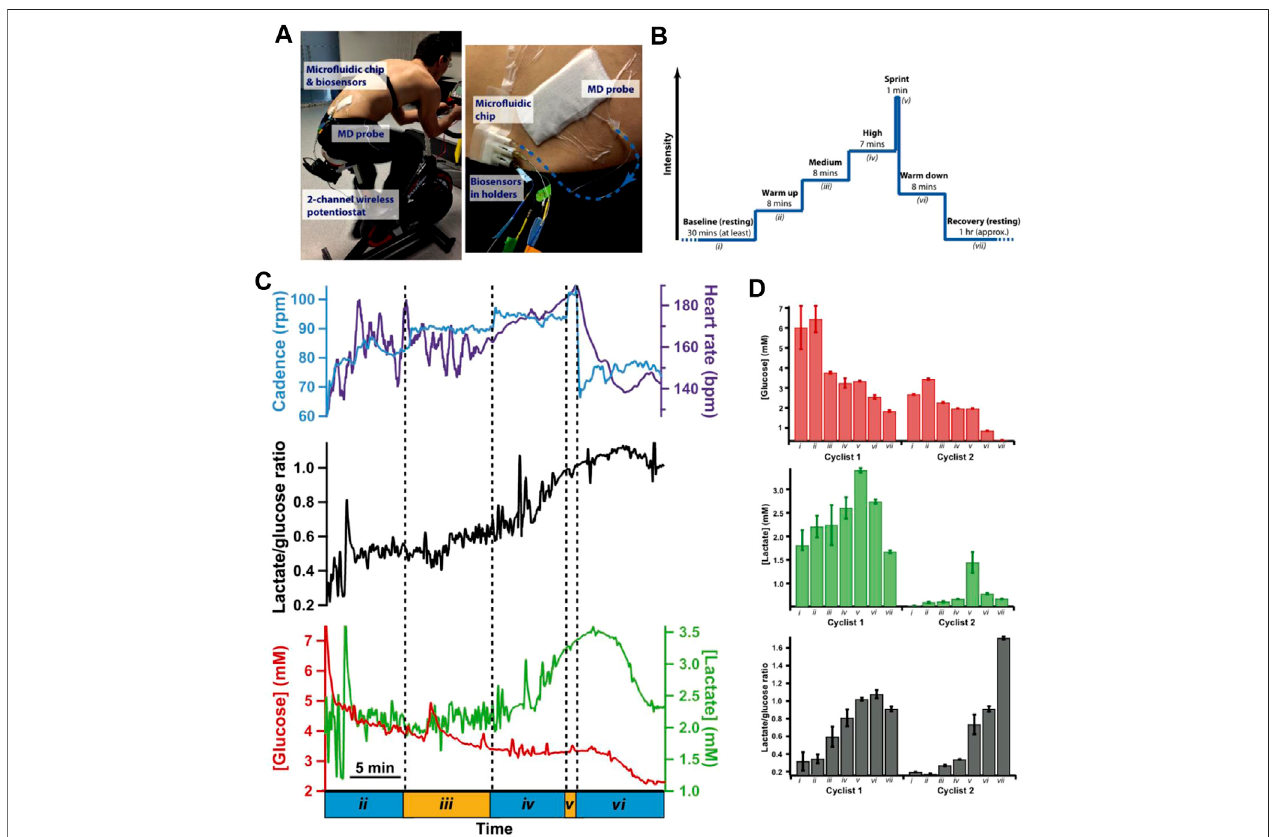
FIGURE6 |(A) Photograph ofamicro fl uidic device tomeasure tissue glucose and lactate levels indialysateduring the cycling protocol, (B) experimental protocol, (C) dialysateglucose,and lactate levelsduring theexercisephase ofthecyclingprotocolsystem. (D) Histogramsshowingmean dialysate levels fortwodifferentcyclists during key points in the cycling protocol (reproduced with permission from Gowers et al., 2015).